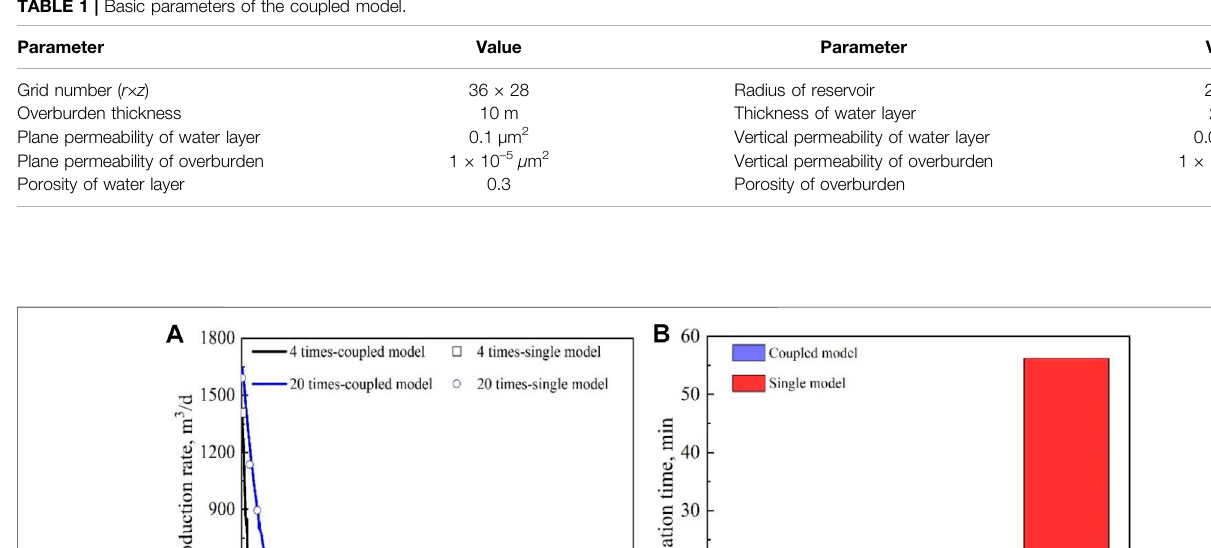
Frontiers in Energy Research |